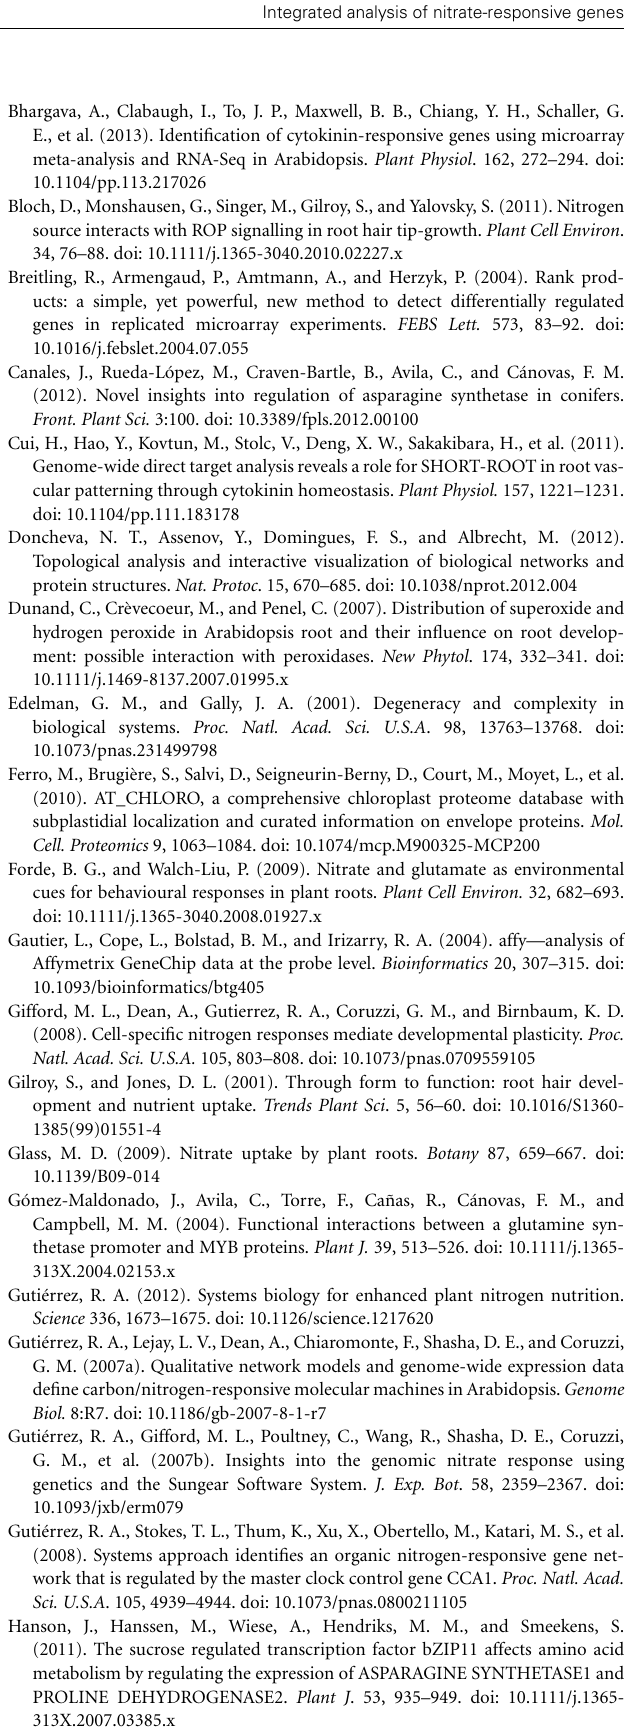
Table S1 | List of 2286 nitrate-responsive genes. Table S2 | Biological processes that are statistically enriched in response to nitrate. Table S3 | List of genes that were commonly expressed in nitrate reductase-null mutant and wild